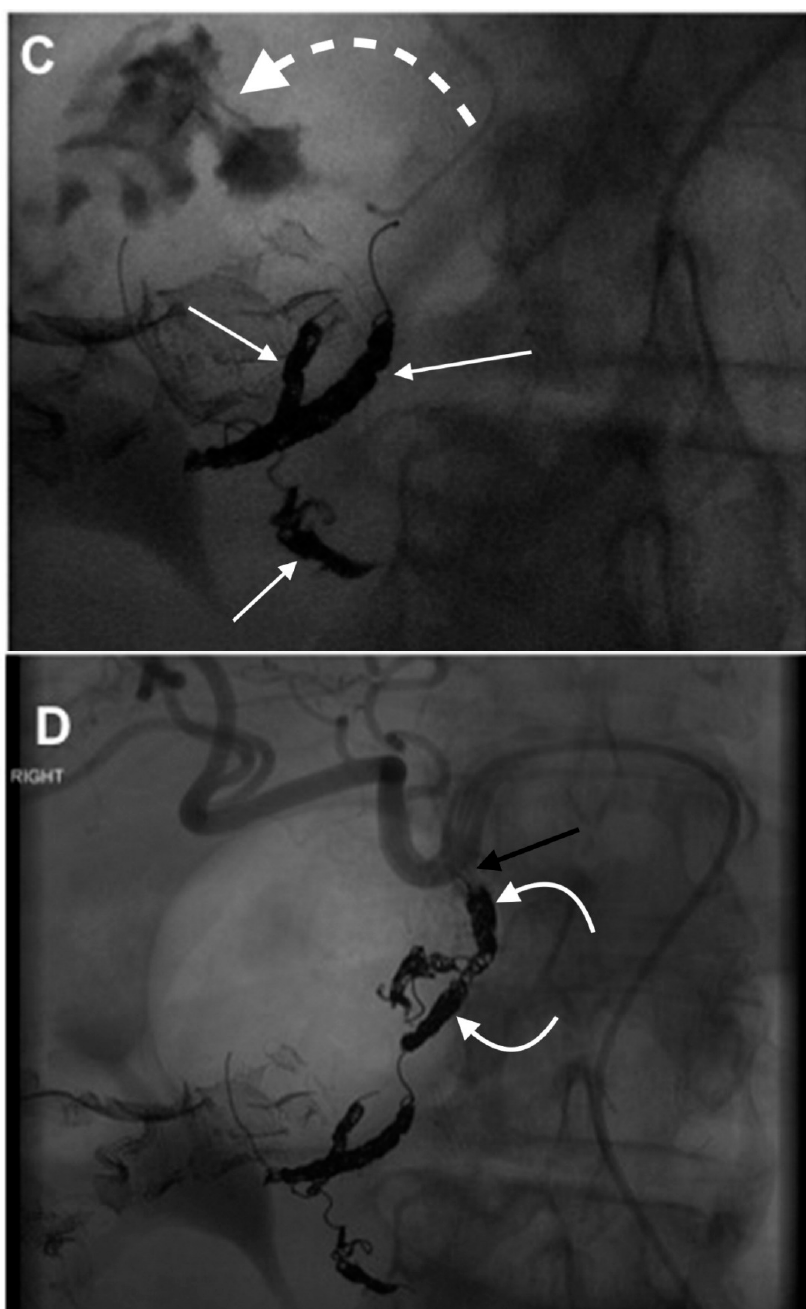
Figure 2. This 78 year old woman presented with melena, hematemesis, hypotension, and acute blood loss anemia. An endoscopy was not performed, given the high volume of blood which was felt to likely obscure the ( A ) Computerized Tomography (CT) images, demonstrating the duodenal perforation (white arrow) in the posterior wall with abnormal appearing GDA coursing directly adjacent to the perforation (white arrowhead). The ( B ) celiac angiogram shows the origin of the GDA (curved black arrow). The ( C ) branches of the GDA that were distal to the duodenal ulcer were coil emobolized (white straight arrows) and the repeat angiogram from the proximal to mid GDA, showed a contrast extravasation into the duodenum (curved dashed arrow). ( D ) Coil embolization (curved white arrows) was done across and proximal to the site of the extravasation up to the origin of the GDA from the common hepatic artery (black